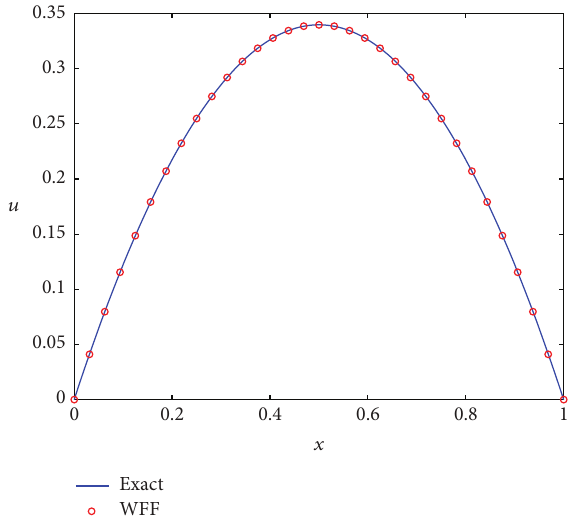
Figure 5: Solution of the BVP: using windowed Fourier frames.